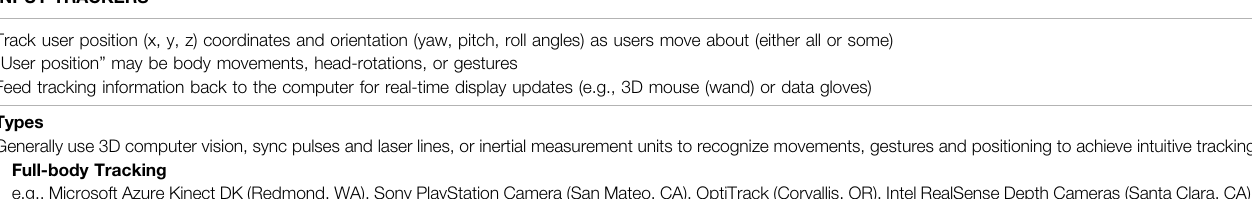
TABLE 1 | Input tracking and output display technologies in consumer-level VR/AR systems. INPUT